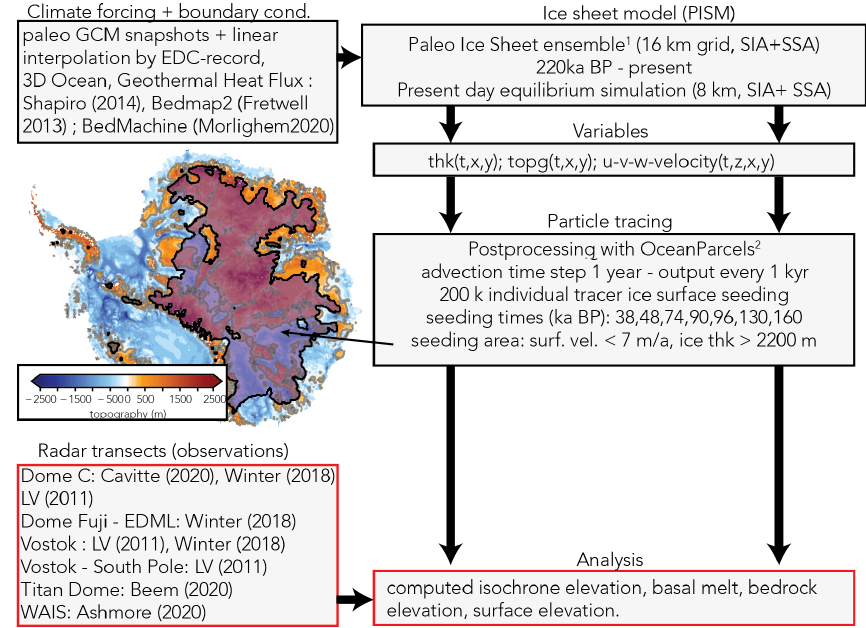
Figure 2. Experimental set-up. The left column depicts the input data to the ISM (climate forcing, geothermal heat flux and initial geometry) and to the data intercomparison (observed radar transects). The contour plot illustrates the area where tracers are seeded (see Video supple- ment). The right column contains the ISM specifications, required variables (thickness, bedrock topography and 3D velocity field) for the tracing scheme and the settings used in OceanParcels (Lange and van Sebille,